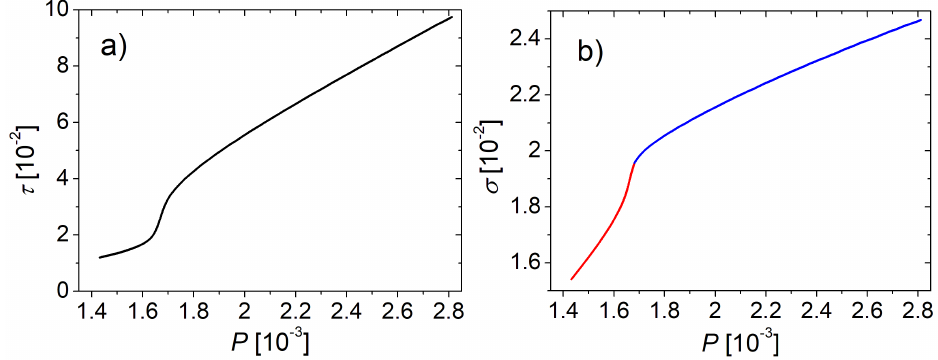
Figure 4. Dependence of the measure of quantum fluctuations τ ( a ) and the mean density ( b ) on the internal pressure P